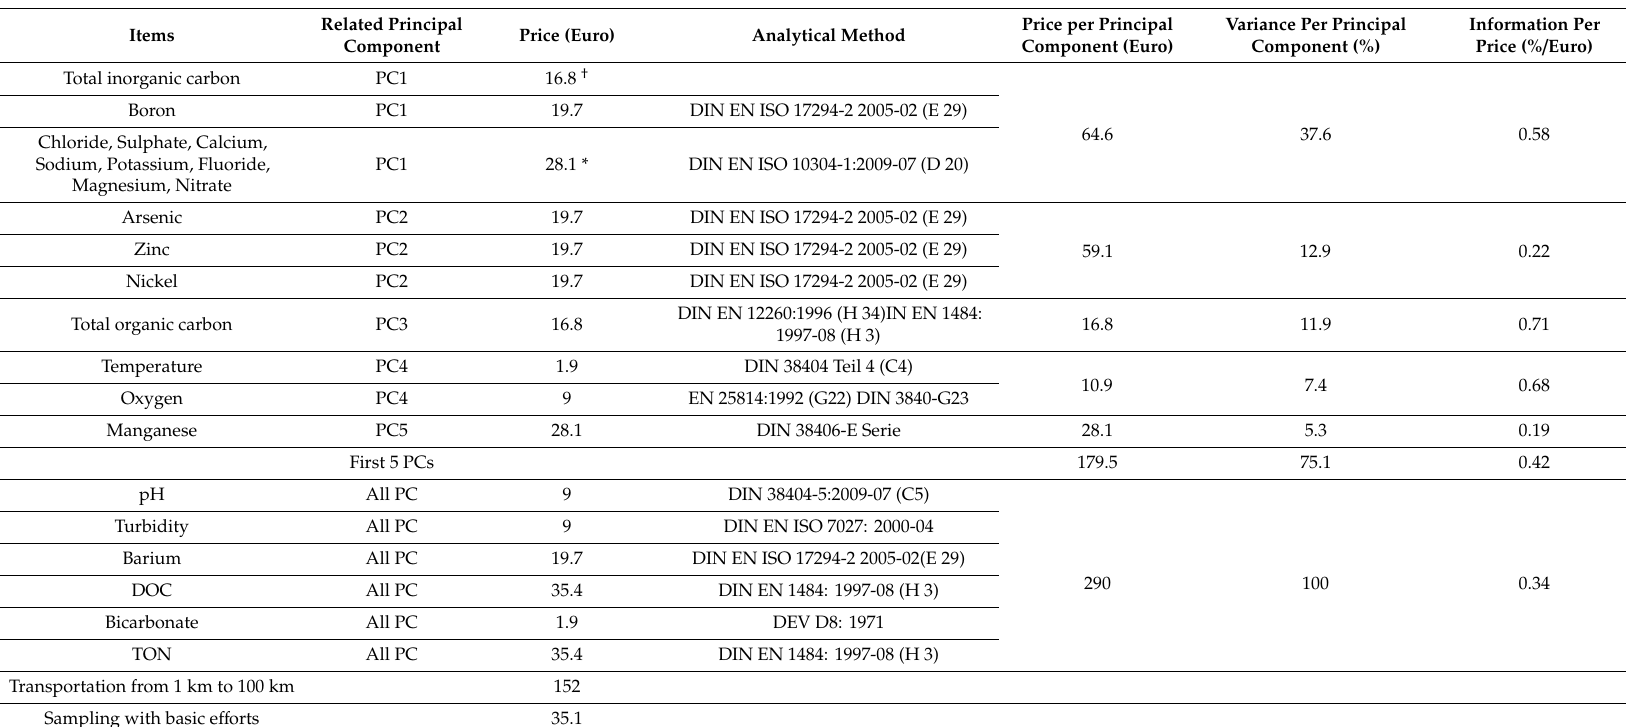
Table 3. Price in euro for transportation, sampling, and laboratory analysis according to Brandenburg services price list in